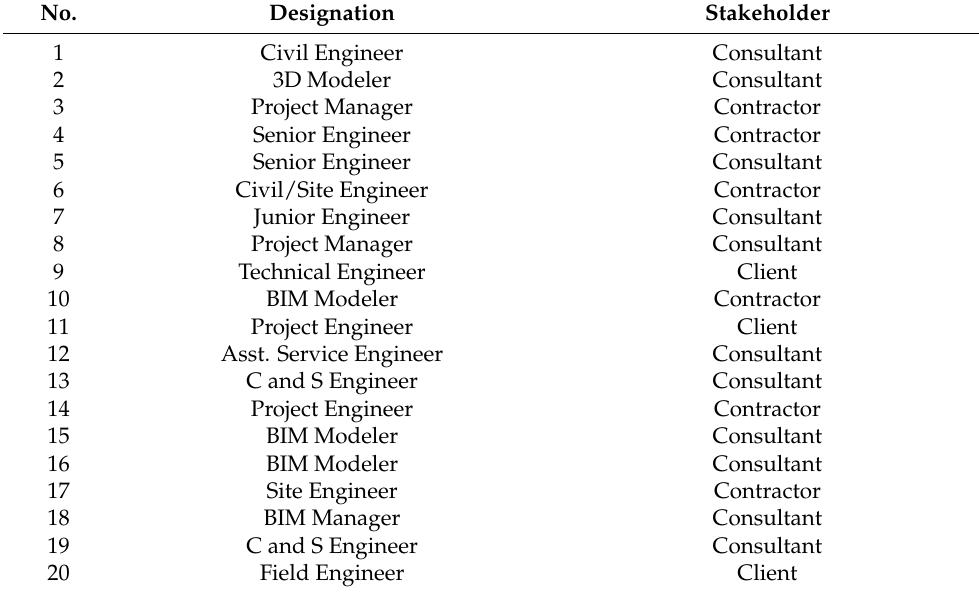
Table 1. Respondent